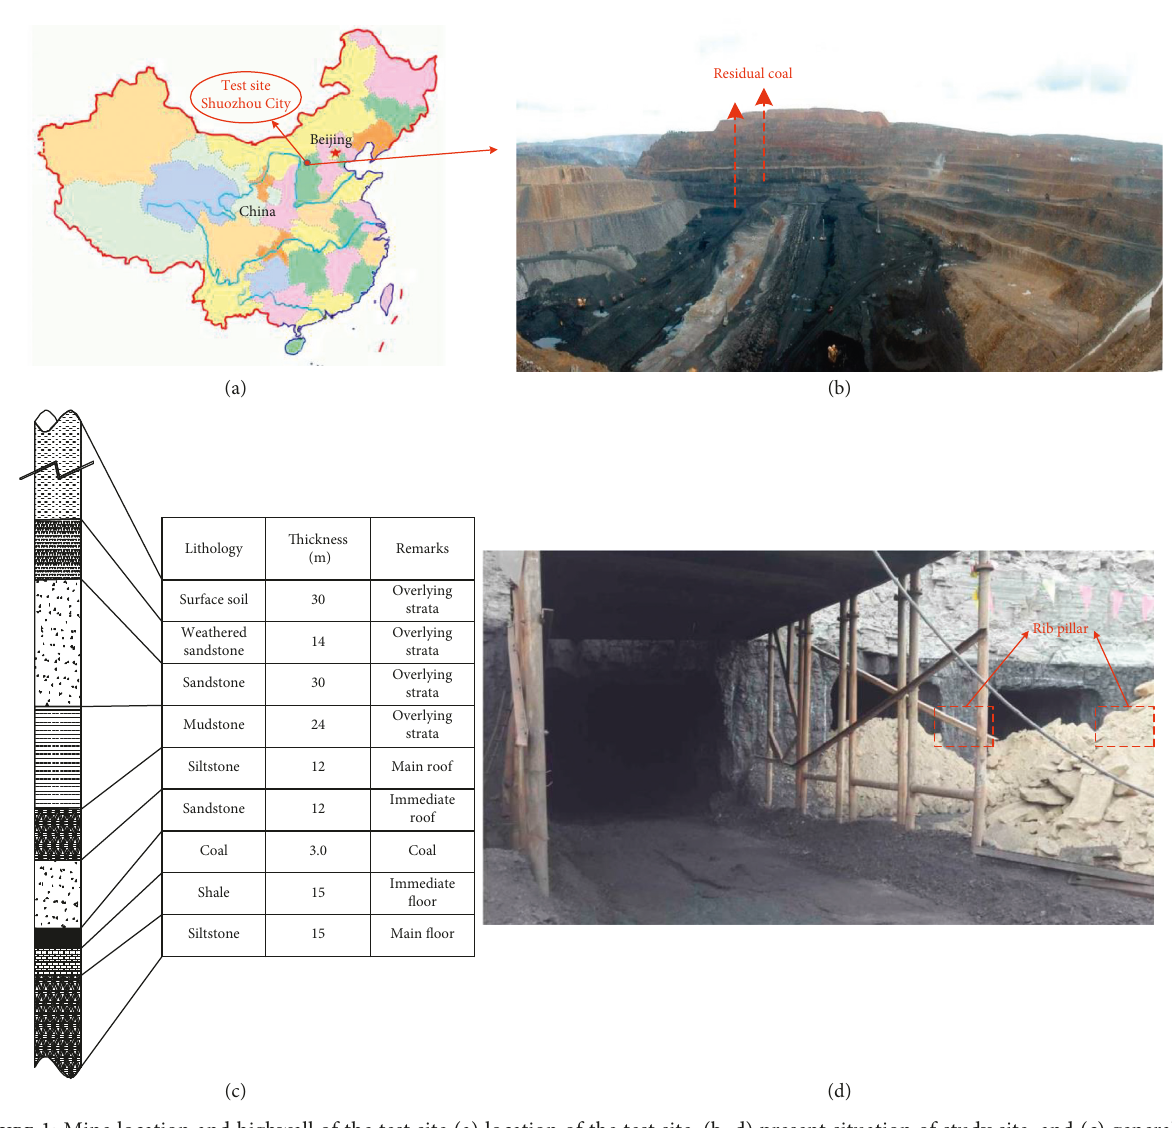
Figure 1: Mine location and highwall of the test site (a) location of the test site, (b, d) present situation of study site, and (c) generalized stratigraphic column of the test